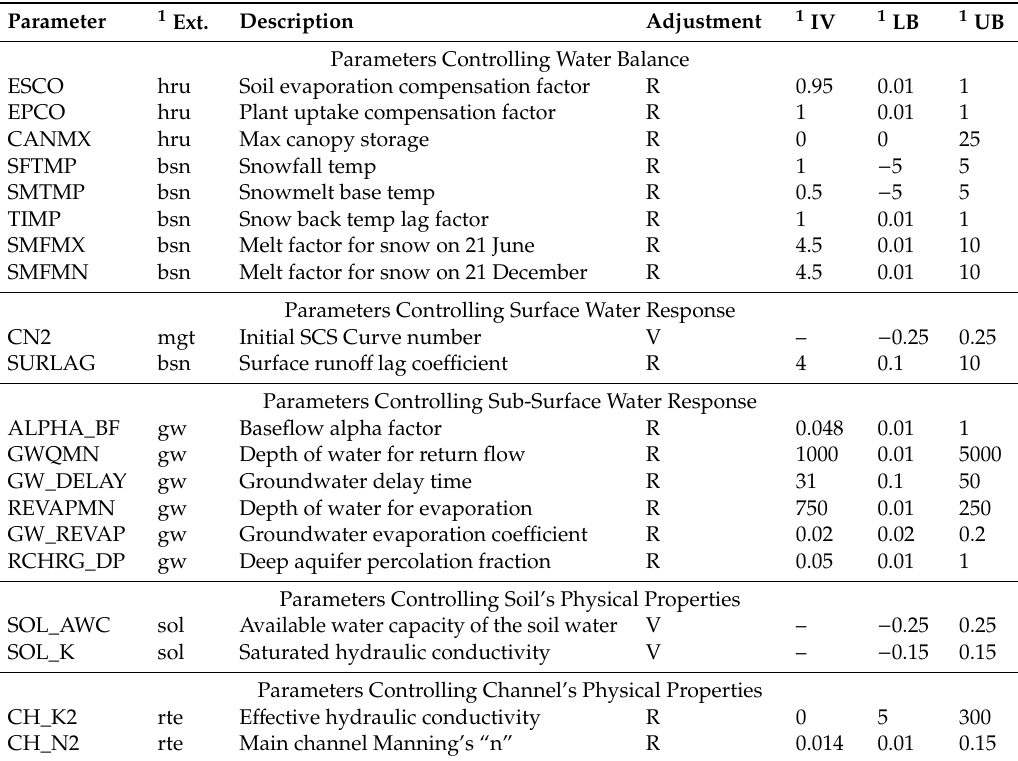
Table 1. SWAT input parameters used for the UWBDR and Walzem Creek watersheds calibration of streamflow and baseflow [8].